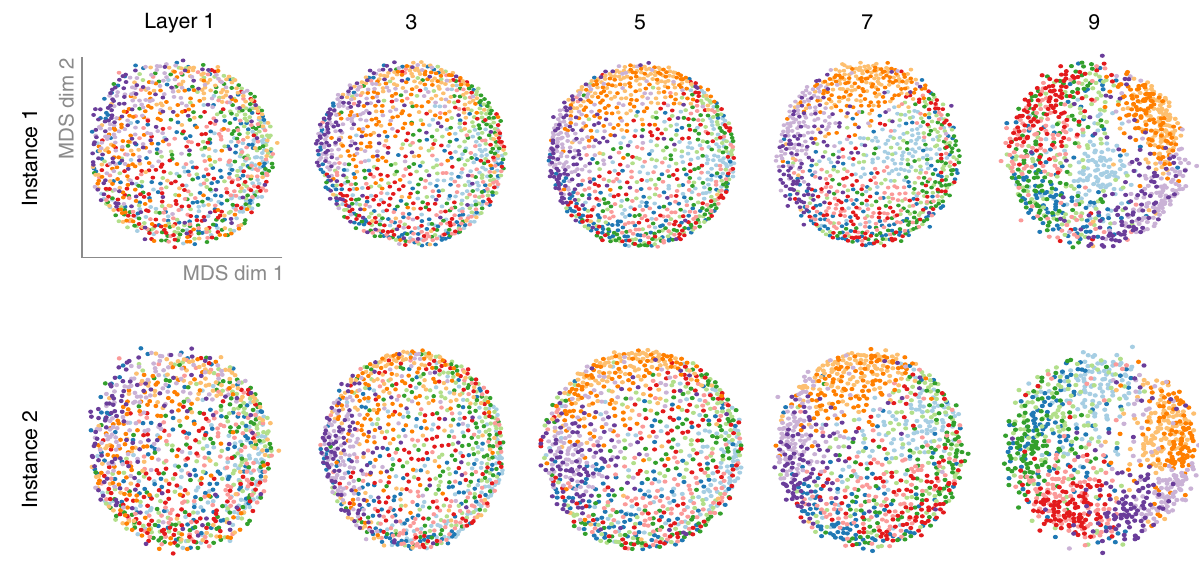
Fig. 2 Representational geometries at different network depths of two DNN instances. The internal representations of two network instances were characterized based on their representational geometries. We computed the pairwise distances (correlation distance) between activity patterns in response to 1000 test stimuli from 10 visual categories and visualized them in 2D via multidimensional scaling (MDS; metric stress criterion; categories shown in different colors). With increasing depth, networks exhibit increased category